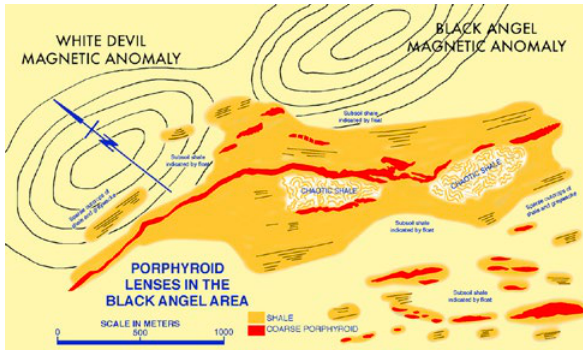
Figure 3. Map of the mysterious porphyroid lenses and magnetic anomalies at the Black Angel prospect, Tennant Creek.